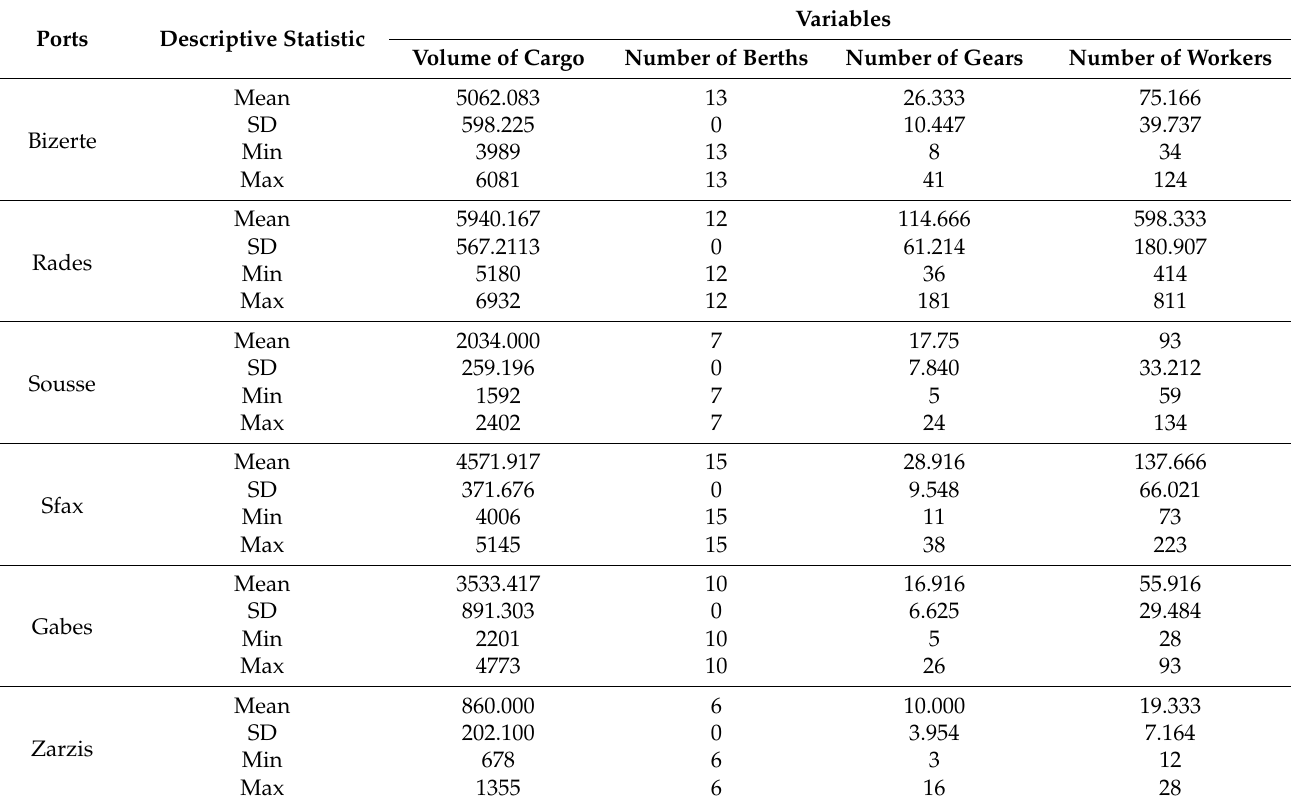
Table 3. Descriptive statistics of the inputs and